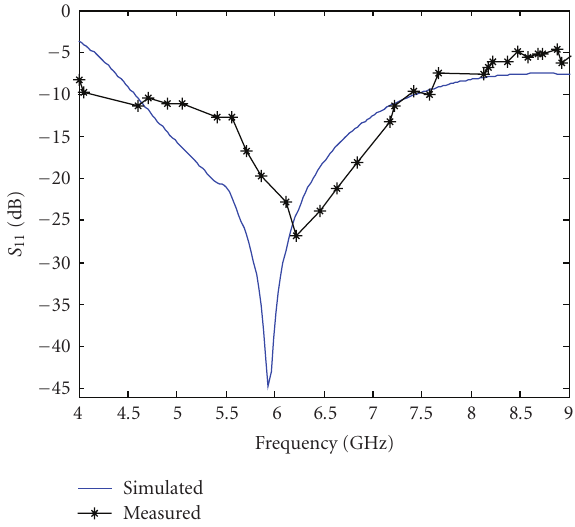
Figure 3: Return loss versus